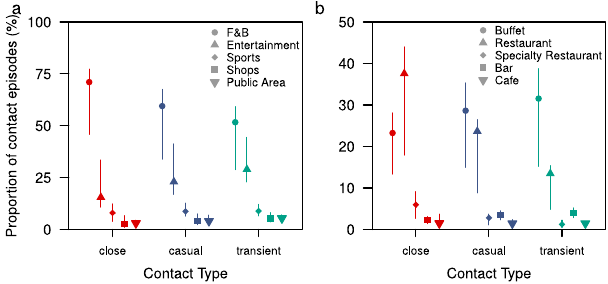
Fig. 3 Type of contact by location of interaction and throughout the sailing. a Proportion of all close, casual and transient contact episodes between passengers of different travelling groups by the location of interaction, b proportion of all close, casual, and transient contact episodes between passengers of different travelling groups by respective F&B locations. Median (shapes), 50% (dark lines) and 95% intervals (light lines) are